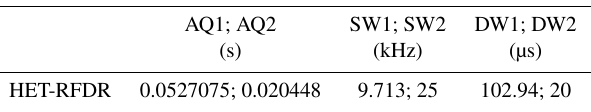
Table 2. Summary of the experimental parameters used in 2D HET- RFDR α -PET SH3